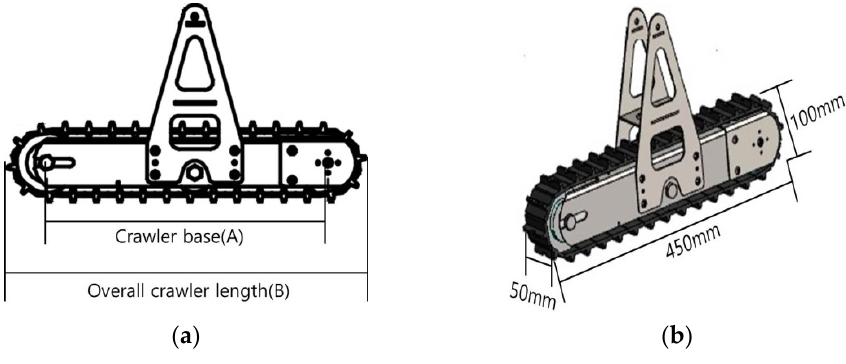
Figure 3. ( a ) Flat caterpillar, ( b ) 3D caterpillar.